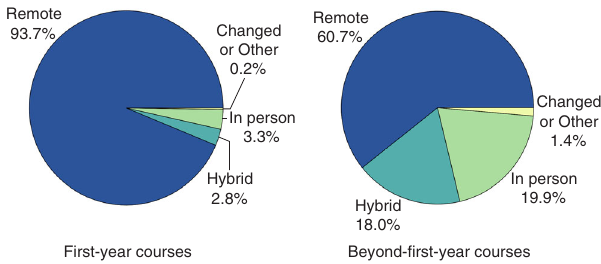
FIG. 1. Percentages of students in FY and BFY courses who participated in their courses entirely remotely, entirely in person, in a hybrid format, or in some other manner (e.g., the modality changed partway through the term). These percentages are of the number of students who responded to this question ( N ¼ 5070 for students in FY courses and N ¼ 433 for students in BFY